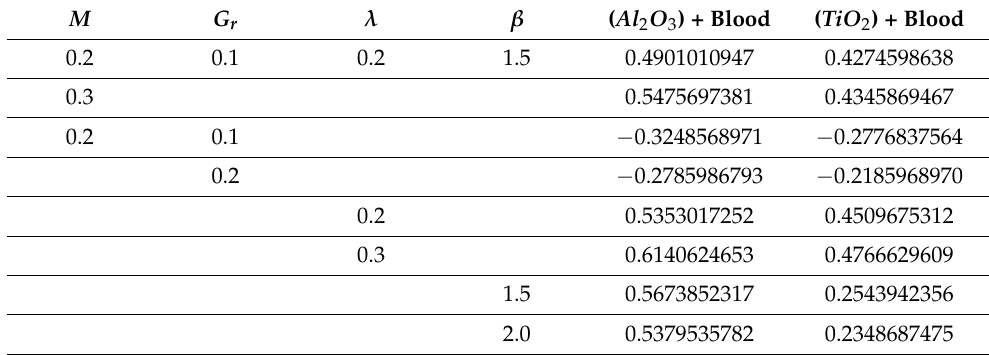
Table 4. Computed values of Re 1 2 C f against several estimations of M , β , λ , and Gr when ξ =